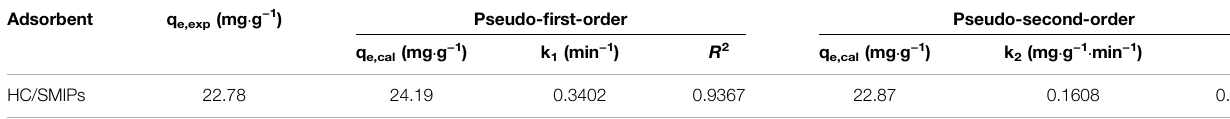
TABLE 1 | Kinetic parameters for adsorption of HC on HC/SMIPs. Adsorbent